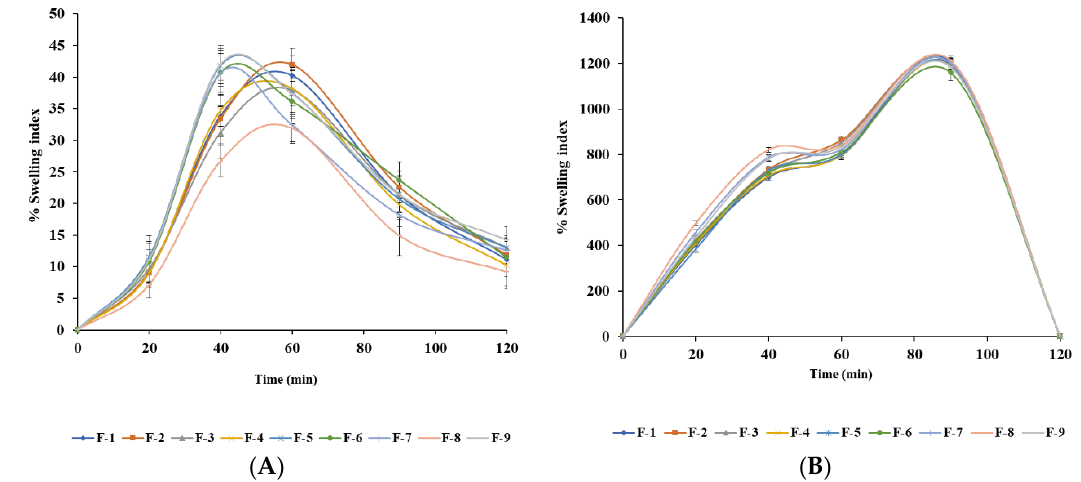
Figure 9. Swelling behaviour of optimized alginate/lecithin beads containing BSO in ( A ) acidic (pH 1.2) and ( B ) buffer (pH 6.8) media. Data were presented as mean ± SD, n = 3.